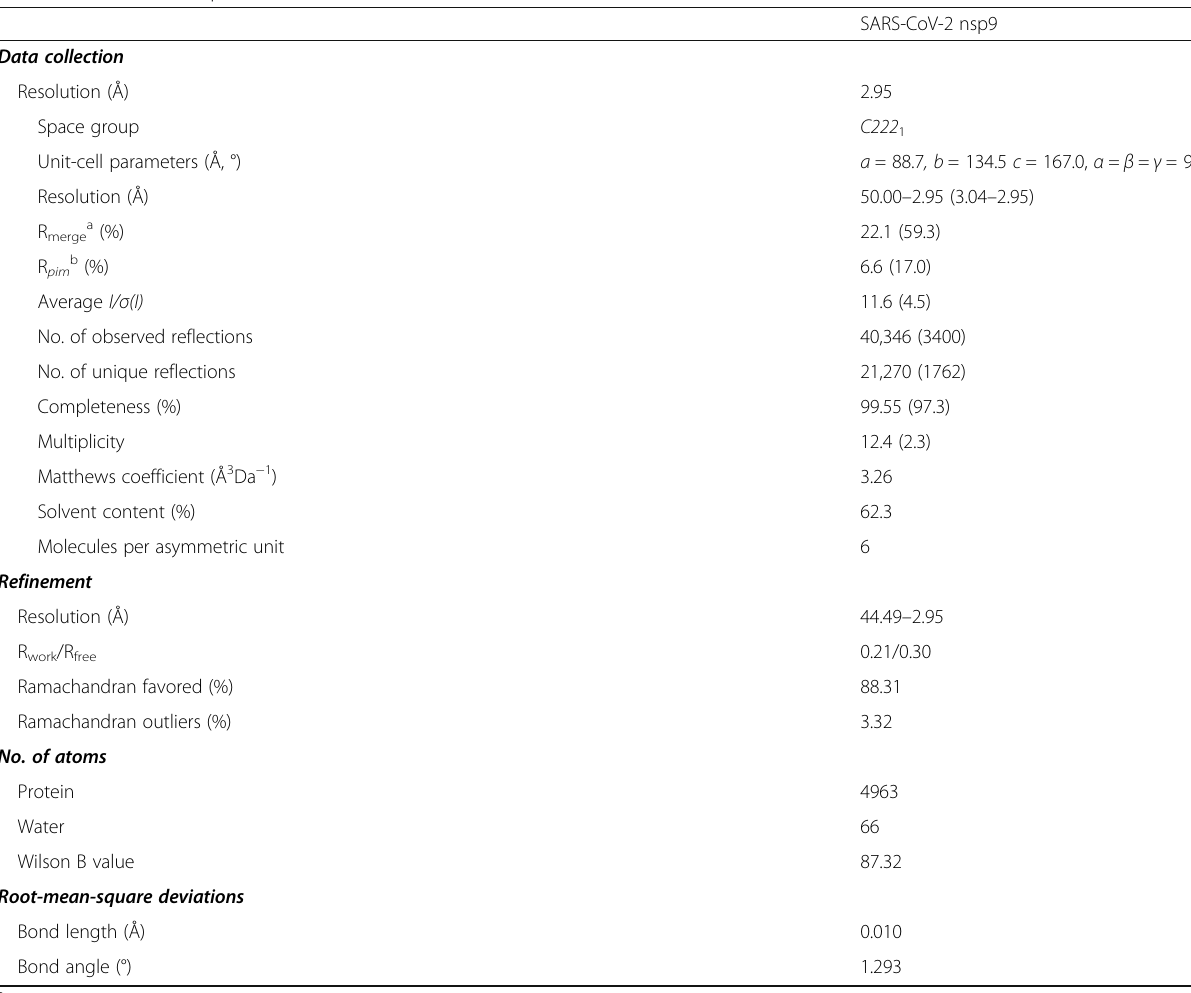
Table 1 SARS-CoV-2 nsp9 data collection and refinement